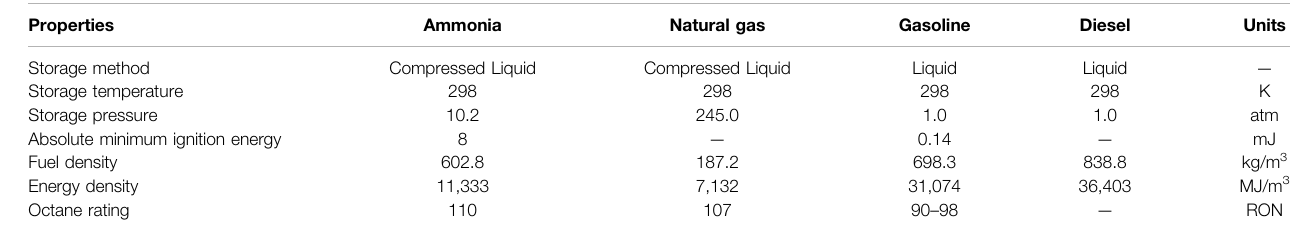
TABLE 2 | Some characteristics of NH 3 versus natural gas, gasoline, and diesel (Dimitriou and Javaid, 2020).